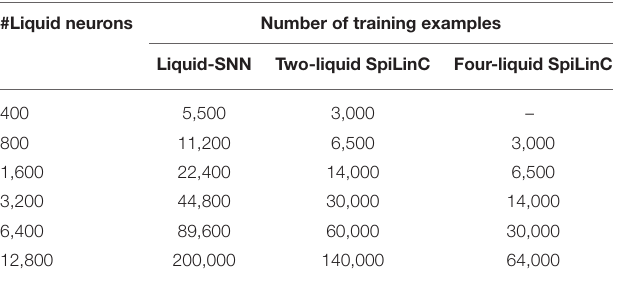
TABLE 5 | Number of examples used to train the Liquid-SNN and SpiLinC for recognizing MNIST digits. #Liquid